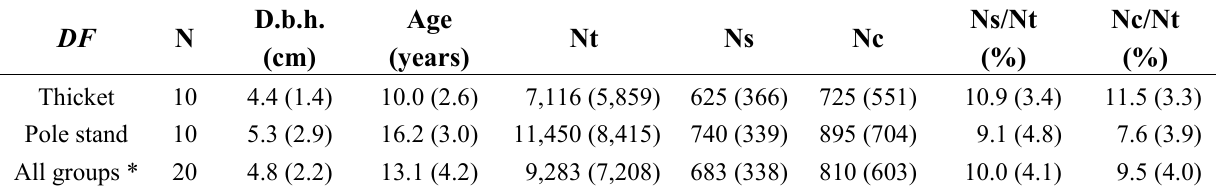
Table 1. Summary of mean stand characteristics of the developmental phases (DF) (Nt—number of trees, Ns—number of crop trees, Nc—number of competitor trees, D.b.h.—diameter at breast height); standard deviation in